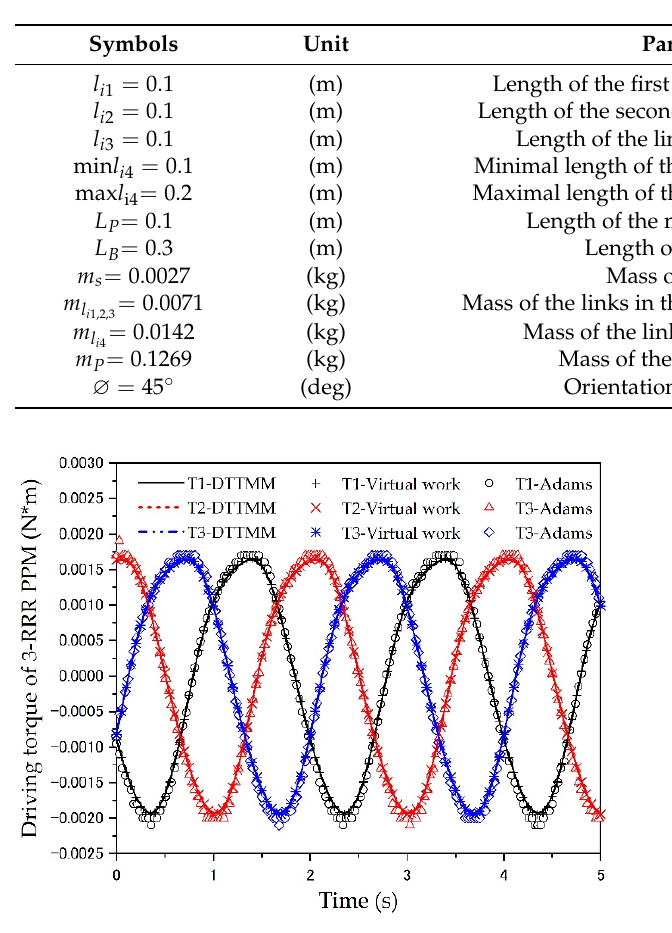
Figure 6. Driving torque of the 3-RRR PPM.